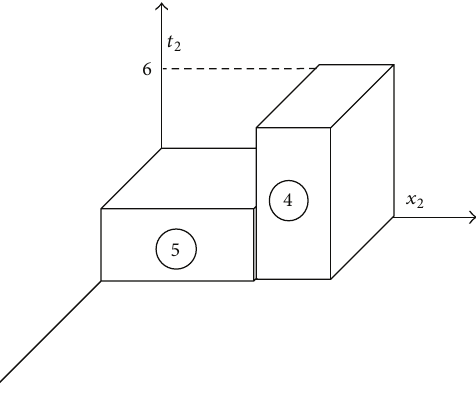
Figure 6: The status of place 2 while activity 4 is